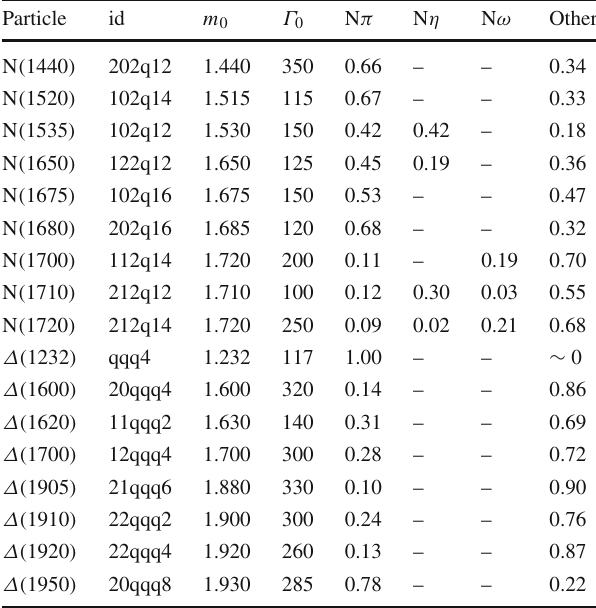
Table 7 Implemented nucleon and Delta resonances, including nomi- nal mass (GeV) and width (MeV), and branching ratios for some